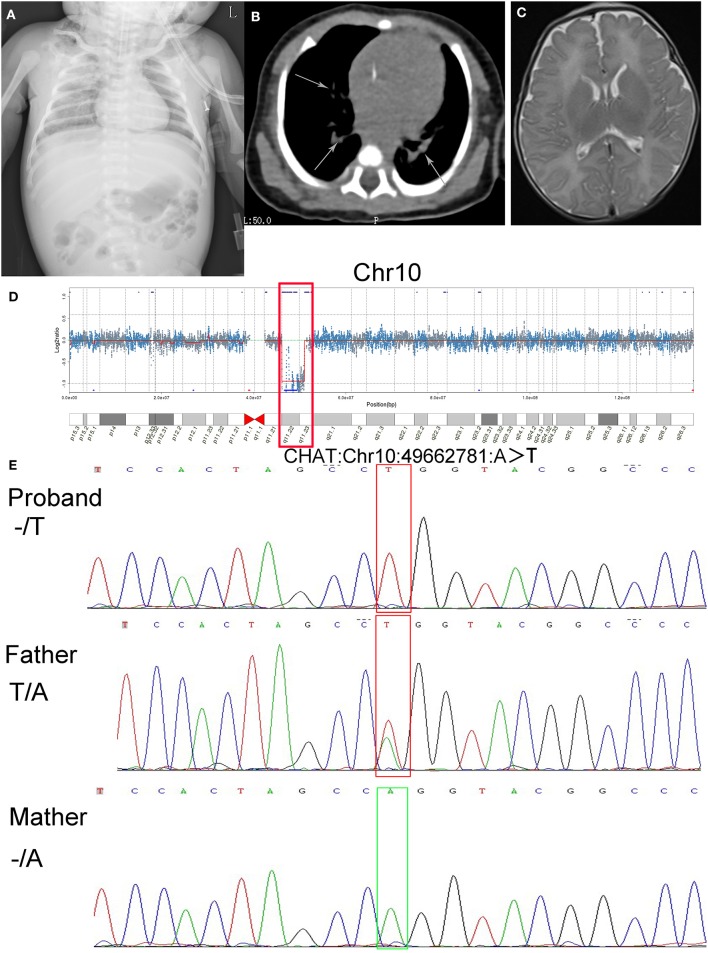
Results of imaging tests and genetic tests, alignment of amino acid sequences, and a schematic of gene structure and protein structure. (A) Chest plain film indicated double-lung texture growing thick and heavy. (B) CT images showed an increasing density of patchy shadows with blurry margins (arrows). (C) The brain MRI showed no abnormalities. (D) The results of CNV-Seq from the patient's genomic DNA sample (q11.22–q11.23 deletion on chromosome 10 is shown in the box). (E) Sanger sequencing of the CHAT gene showed the hemizygous mutation c.1976A>T (p.Gln659Leu) in the proband, absence of the mutation in the mother and heterozygous mutation in the father.